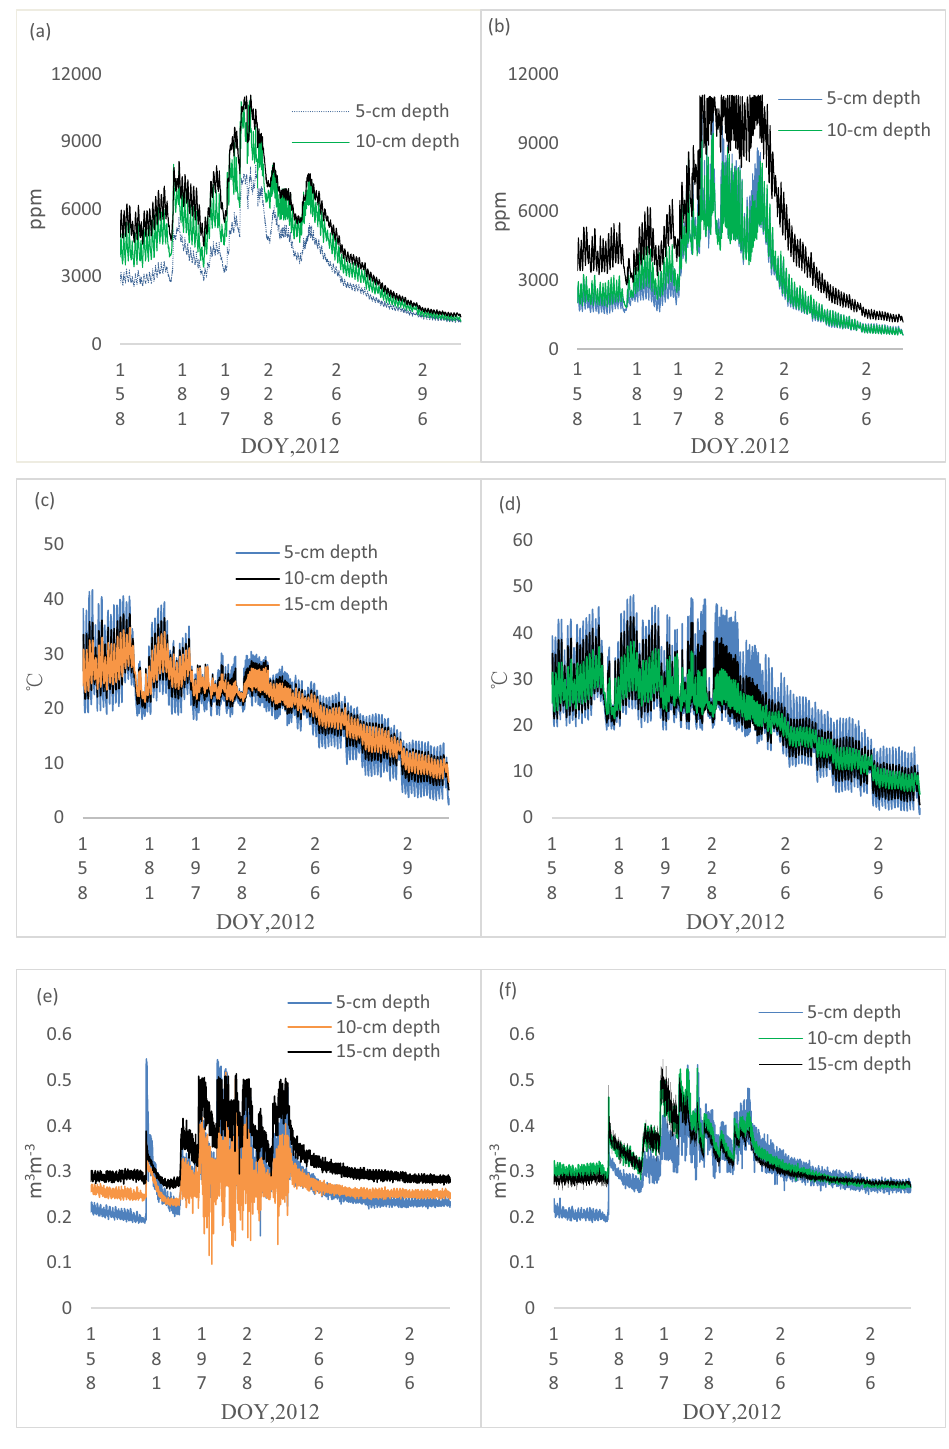
Figure 2. Seasonal variation of soil profile (a) CO 2 concentration in the TC treatment, (b) CO 2 concentration in the MC treatment, (c) temperature in the TC treatment, (d) temperature in the MC treatment, (e) moisture in the TC treatment, (f) moisture in the MC